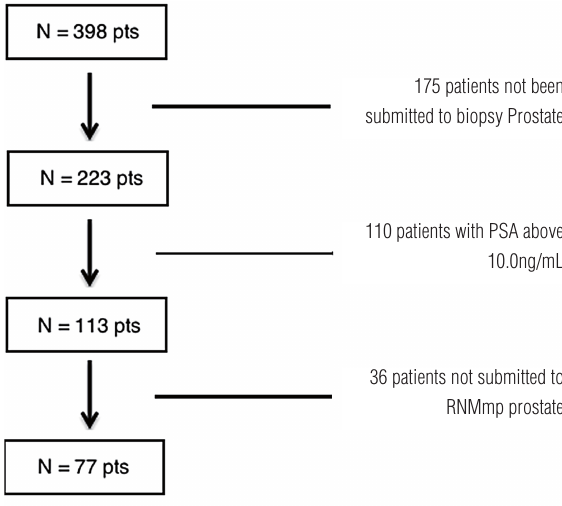
Figure 1 - Study design–175 patients not submitted to prostate biopsy 110 patients with PSA above 10.0ng/mL 36 patients not submitted to prostate